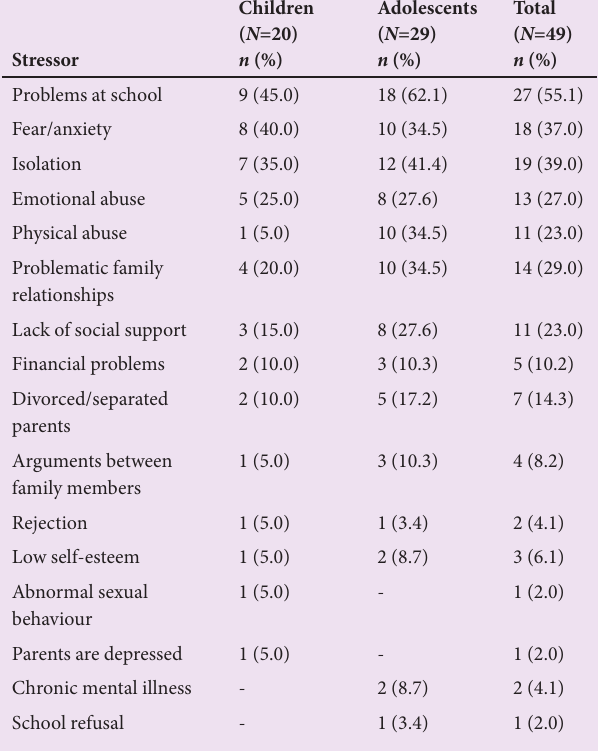
Table 4. Traumatic events identified in children and adolescents with PTSD*